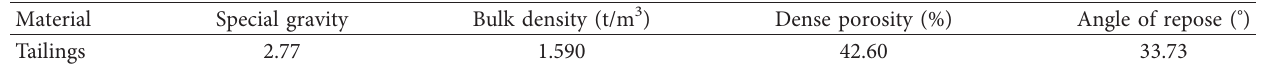
Table 1: Physical properties of tailings.